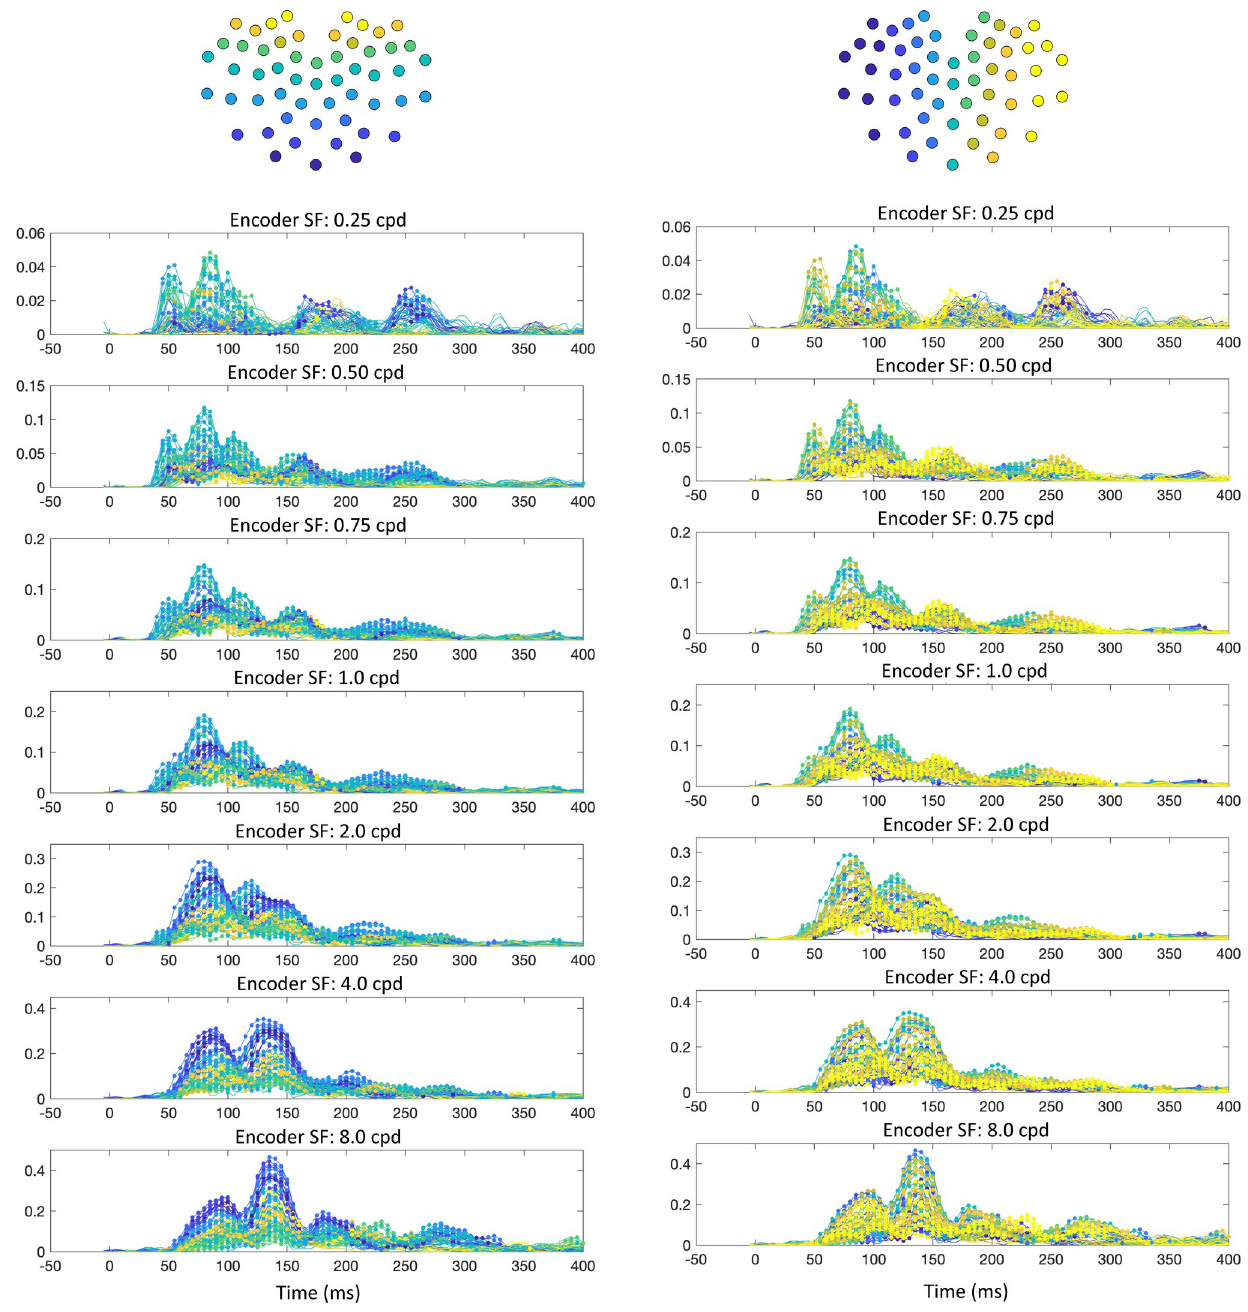
Fig 5. Encoder probability over time, averaged across participants. The y-axes show participant-averaged encoder probability (note that the axes are different across SF peak), with time (ms) on the x-axes. Each trace is from a specific electrode. Probabilities that were above the lower bound of 95% confidence intervals across participants are indicated with a marker point. The electrode traces are color-coded topographically in two ways (illustrated at the top of each set of plots). The left-hand plots are coded from ventral-posterior to dorsal-posterior portions of the scalp, with the right-hand side coded from left to right across the